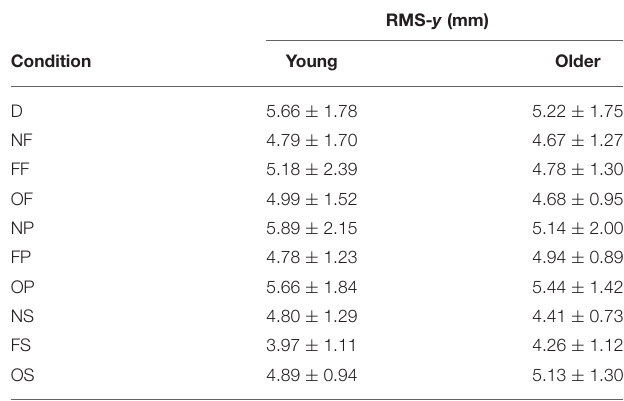
TABLE 2 | RMS of COP coordinate timeseries on the medial/lateral ( x ) axis in young ( n = 12) and older ( n = 12) participants during different visual scene conditions.